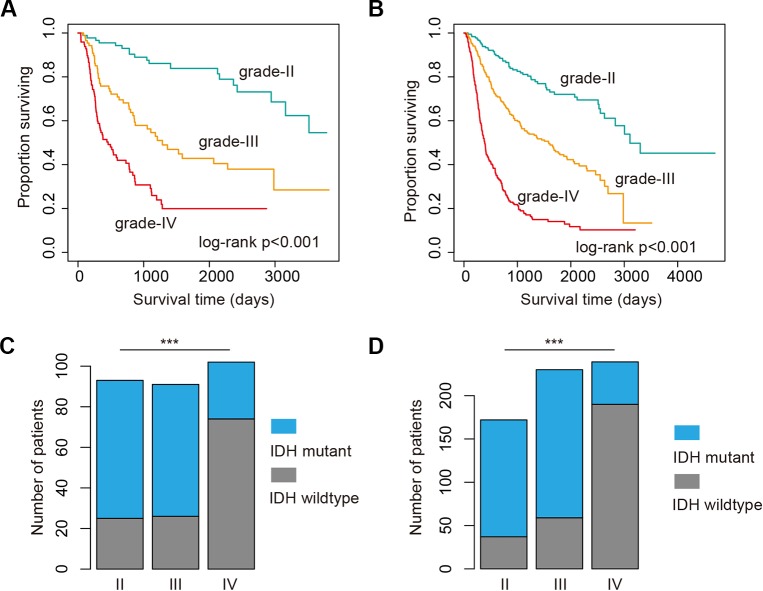
High grade glioma patients with poor survival and less isocitrate dehydrogenase (IDH) mutation. (A) Kaplan–Meier plot indicating survival of glioma patients with mutation data in different grades. (B) Kaplan–Meier plot indicating survival of glioma patients with expression data in different grades. (C) The proportion of patients with IDH mutation or wild type in different grades. Those patients were with mutation data. (D) The proportion of patients with IDH mutation or wild type in different grades. Those patients were with expression data. ***P < 0.001.